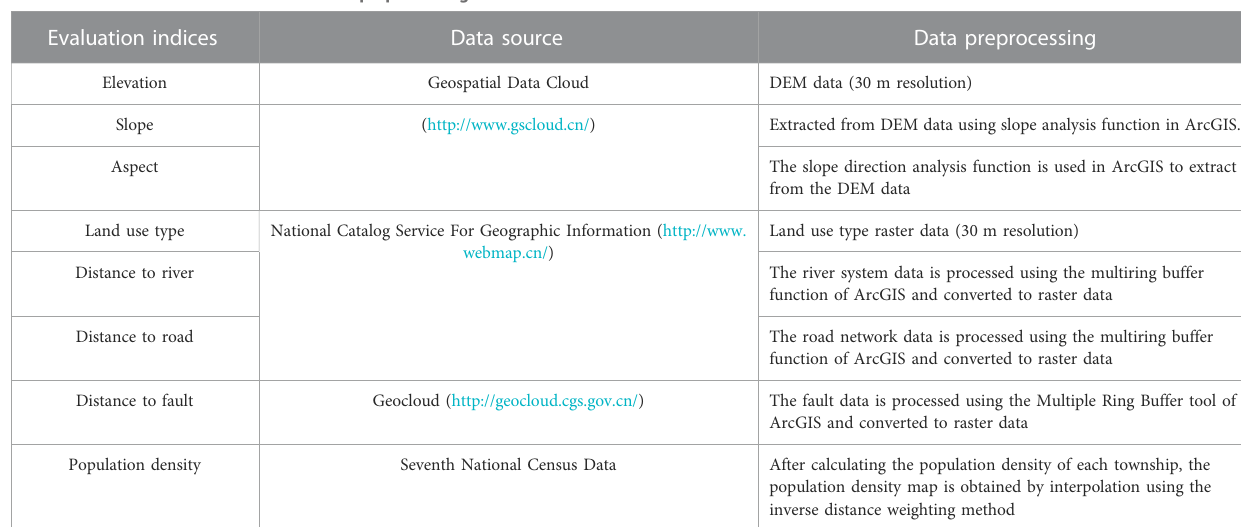
TABLE 2 Evaluation index data sources and